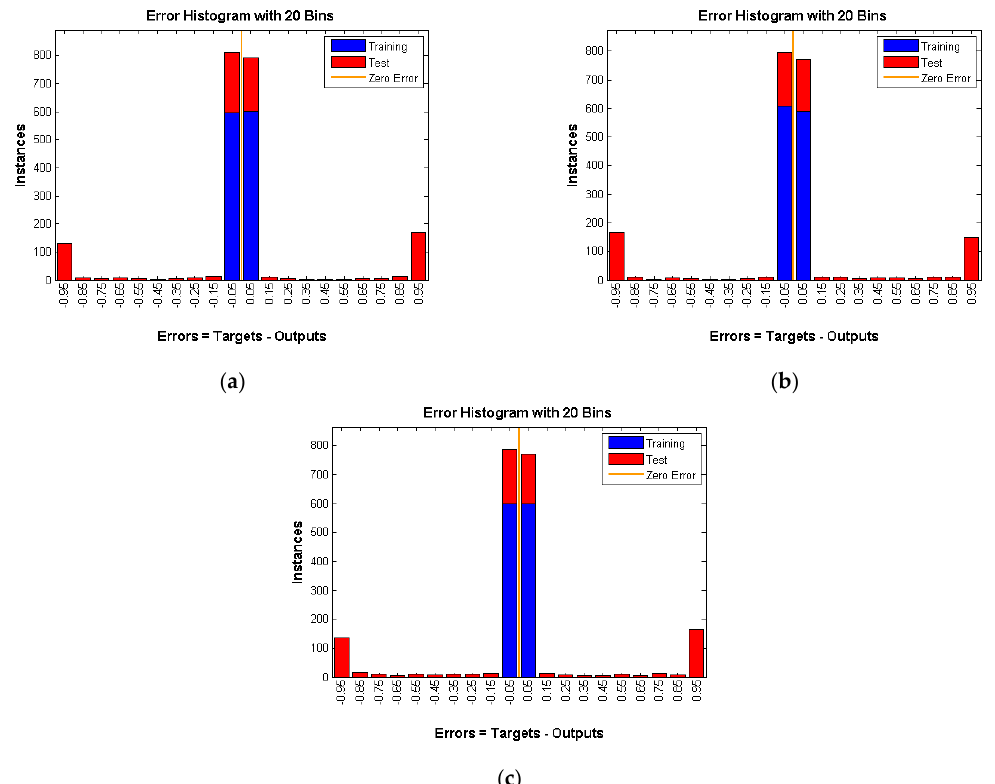
Figure 11. DAD with rate of ( a ) 0.05; ( b ) 0.1 and ( c ) 0.15.